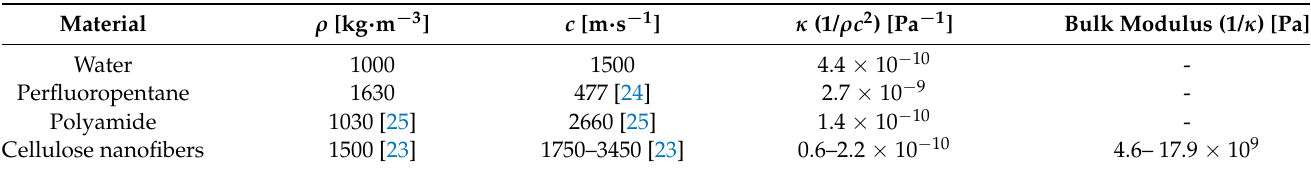
Table 1. Material properties at 25 ◦ C. Tabulated values for PFP obtained from the manufacturer. The phase velocity of CNF is highly dependent on the orientation, as CNF is highly anisotropic